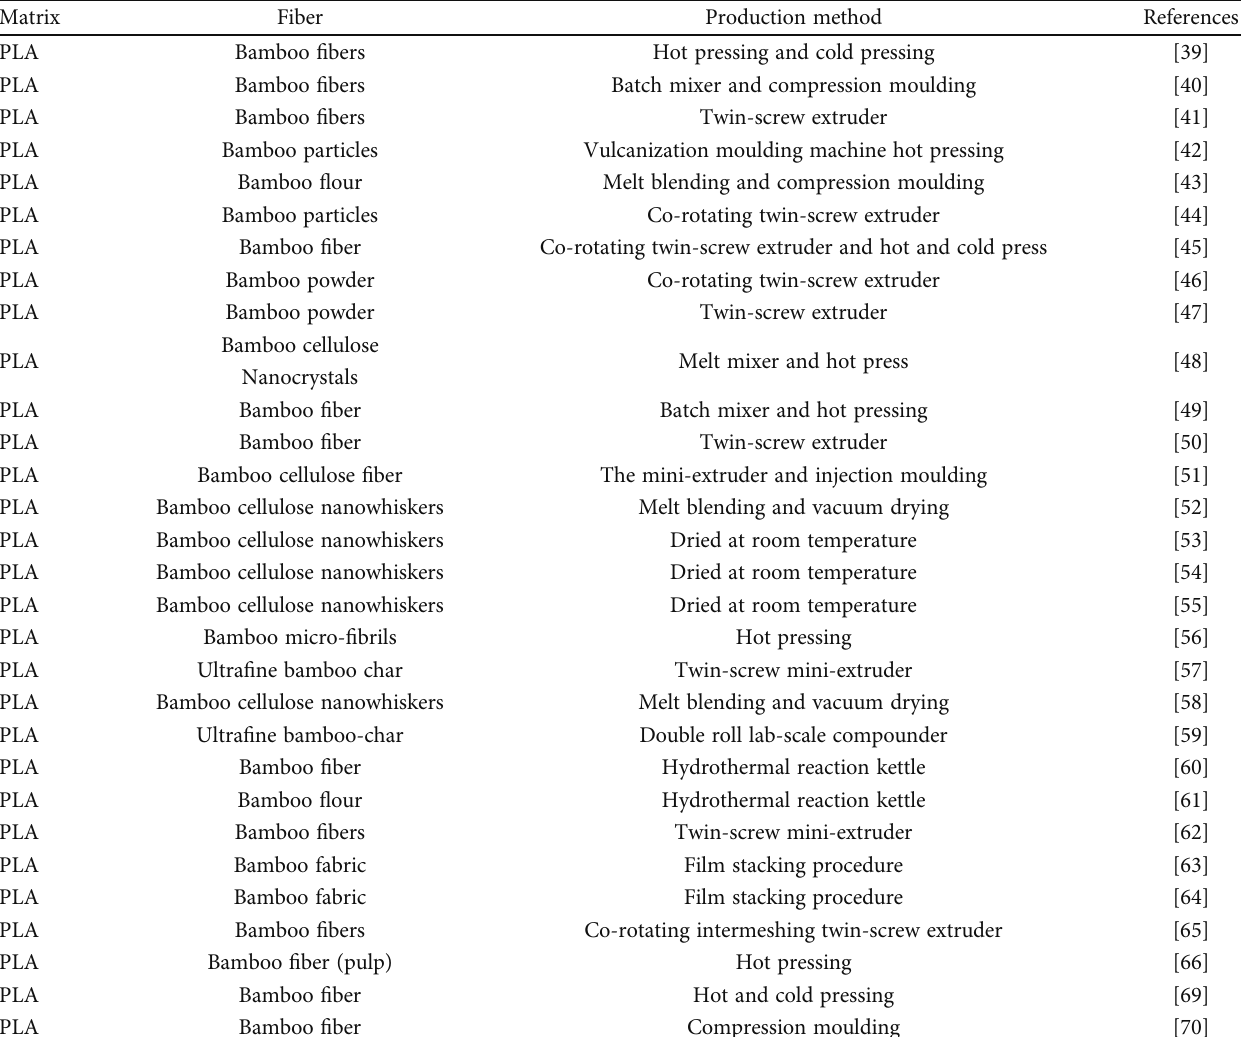
Table 4: Bamboo fi ber – reinforced PLA-based polymer composite production